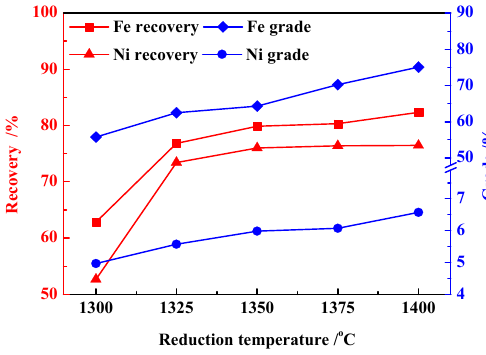
Figure 5. Effects of reduction temperature on grades and recoveries of Ni and Fe.